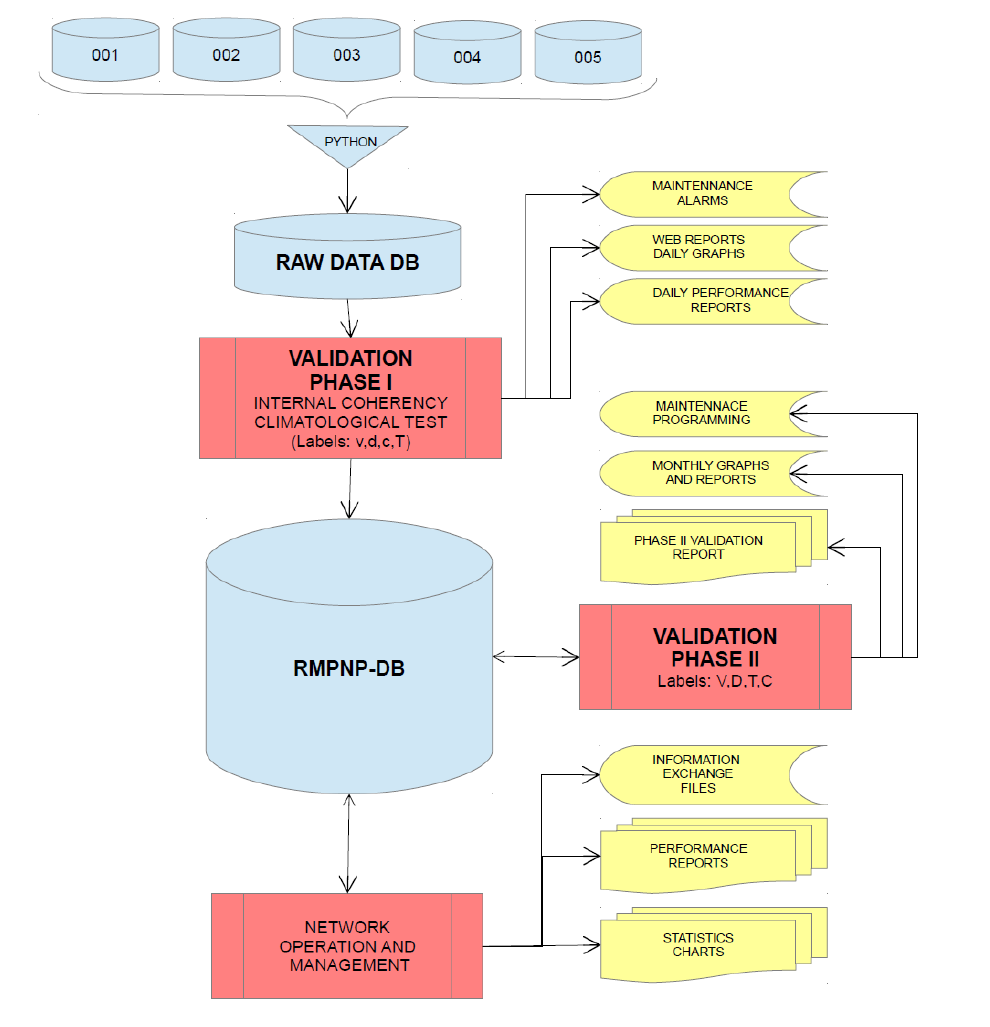
Figure 2. Flow chart of RMPNP data management and QAQC